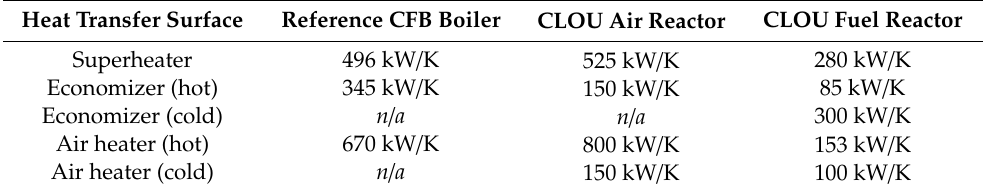
Table 4. Convective heat transfer surface conductances in the reference plant boiler, and CLOU system air and fuel reactor back